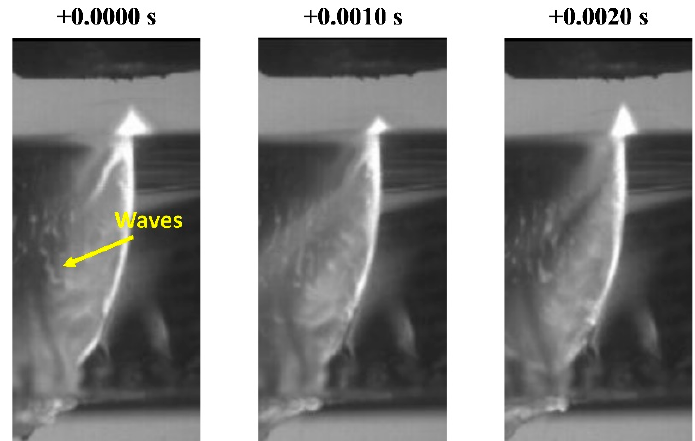
Figure 13. Waves on the molten material flowing along the cutting edge during laser cutting of glass (Processing conditions: Laser power P = 1400 W, cutting speed v c = 1400 mm/min, conical nozzle, nozzle diameter d = 2 mm, stand-off Z = 1.5 mm, assist gas: argon, supplying pressure p = 8 bar). Reprinted with permission [57]; Copyright 2011 IOP Publishing.